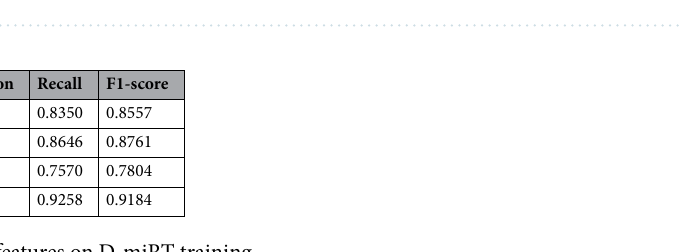
Table 4. The impact of input features on D-miRT